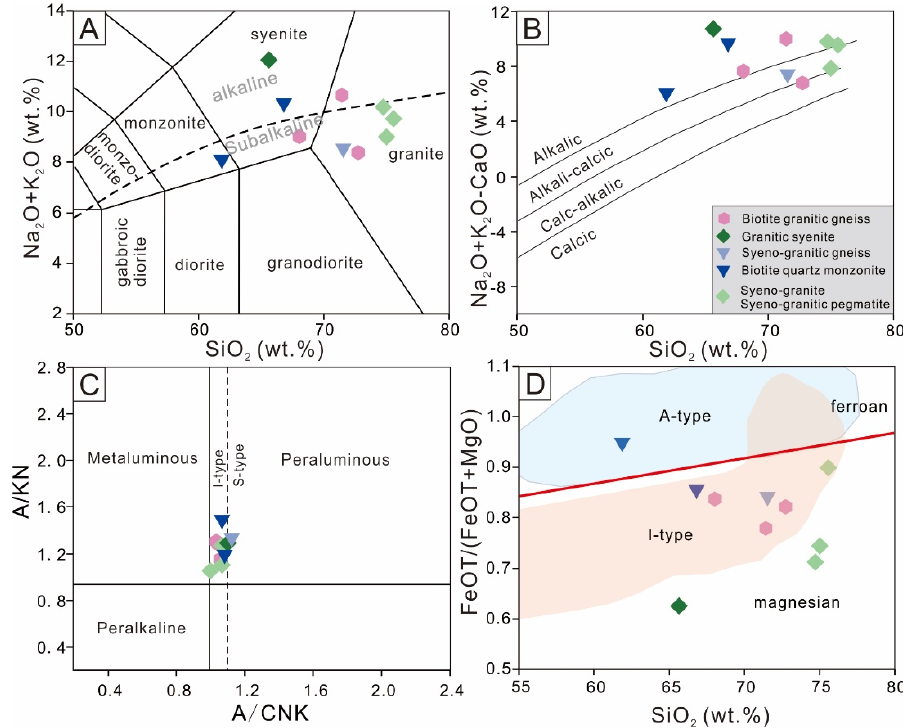
Figure 4. Geochemical classification plots of the biotite granitic gneiss, syeno-granite, syeno-granitic pegmatite, syeno-granitic gneiss, granitic syenite, and biotite quartz monzonite. ( A ) Total alkalis vs. silica plot [44]. ( B ) (Na 2 O + K 2 O − CaO) − SiO 2 [45] classification diagram showing potassic contents and calcic to alkalic. ( C ) A/NK [molar Al 2 O 3 /(Na 2 O + K 2 O)] vs. A/CNK [molar Al 2 O 3 /(CaO + Na 2 O + K 2 O)] for evaluating peralkaline, metaluminous, and peraluminous melt compositions [46]. ( D ) FeO T /(FeO T + MgO) − SiO 2 showing ferroan and Magnesian [45].